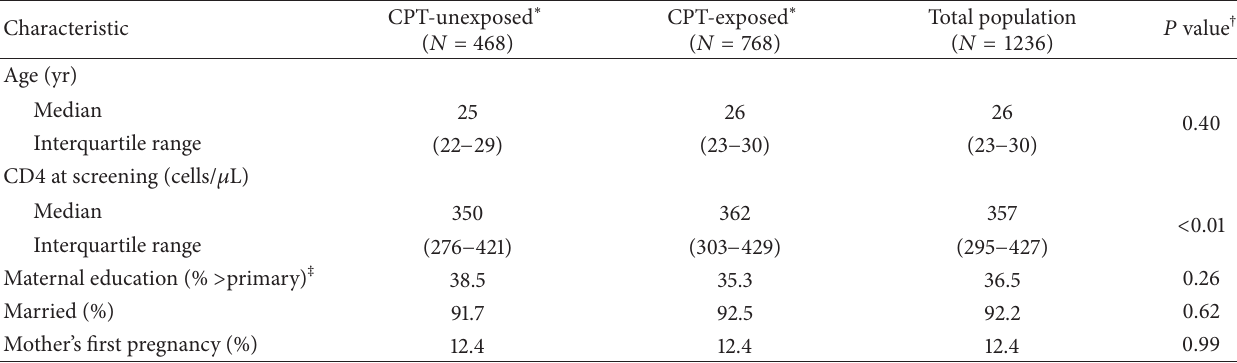
Table 1: Baseline characteristics of 1236 pregnant women by CPT exposure status.